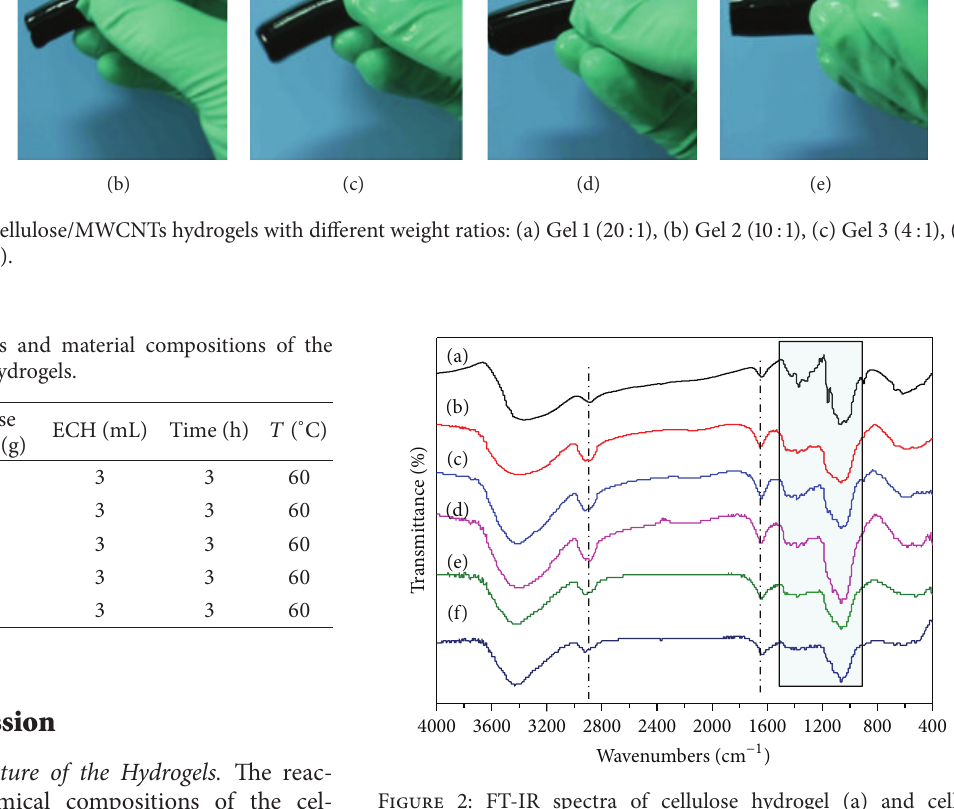
Figure 2: FT-IR spectra of cellulose hydrogel (a) and cellu- lose/MWCNTs hydrogels: (b) Gel 1, (c) Gel 2, (d) Gel 3, (e) Gel 4, and (f) Gel